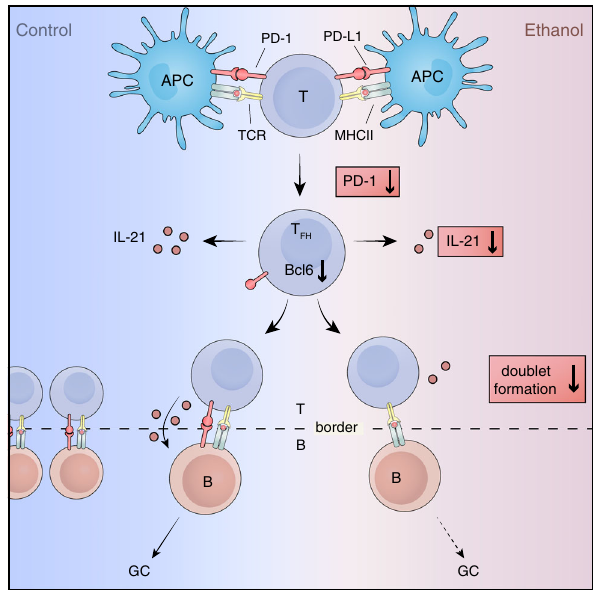
Fig. 9 Effect of alcohol on immune response. Our fi ndings indicate that the exposure to alcohol causes a reduction in T follicular helper cell master transcription factor Bcl6. Additionally, PD-1 and IL-21 are also reduced. Based on fl ow cytometry and immunohistology analysis, there are less T FH : B cell co-localization and conjugate formation, followed by observed lower autoantibody titers and mitigated disease